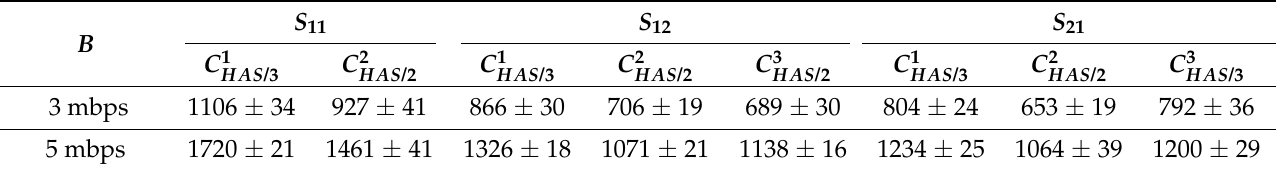
Table 5. The average bitrate r (kbps) of each client running the fairness